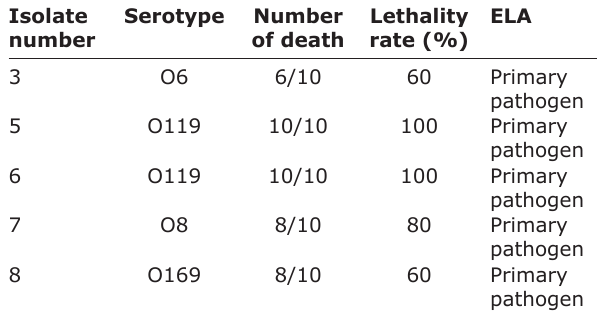
Table-7: Results of ELA.